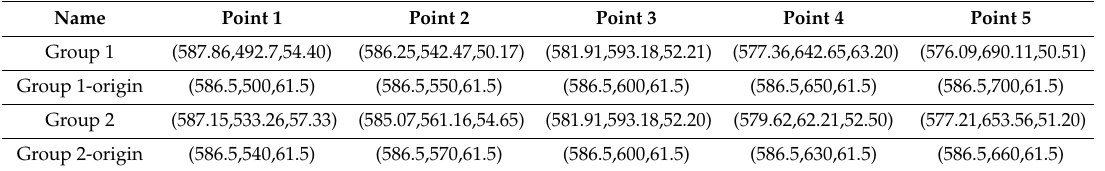
Table 3. Coordinate points list (Two sets of coordinate points).